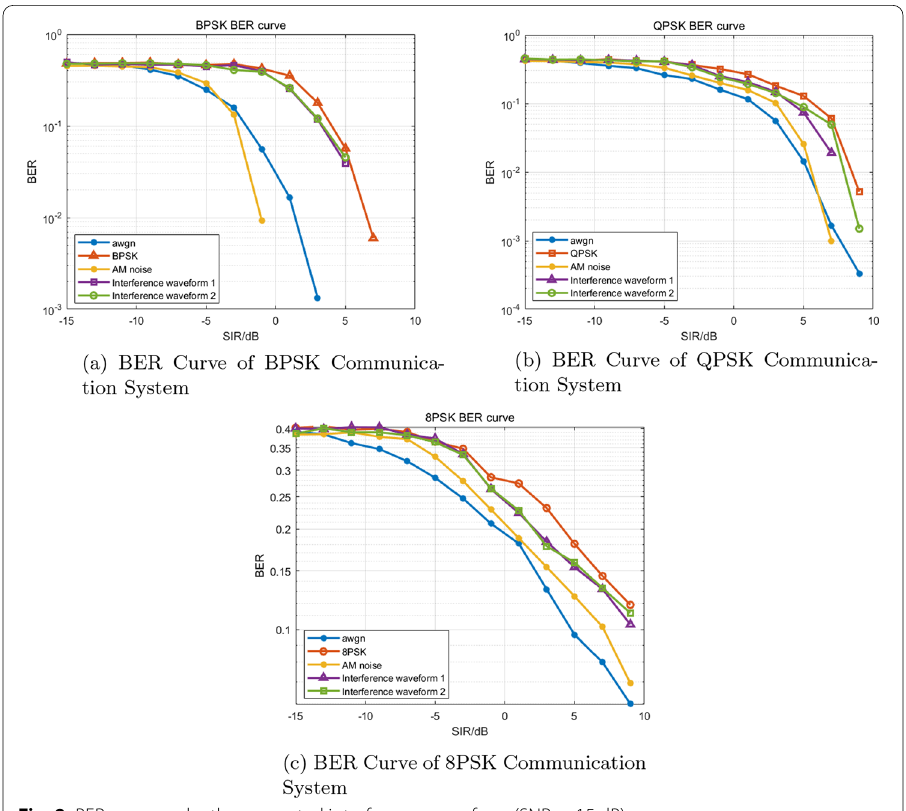
Fig. 8 BER curve under the generated interference waveform (SNR